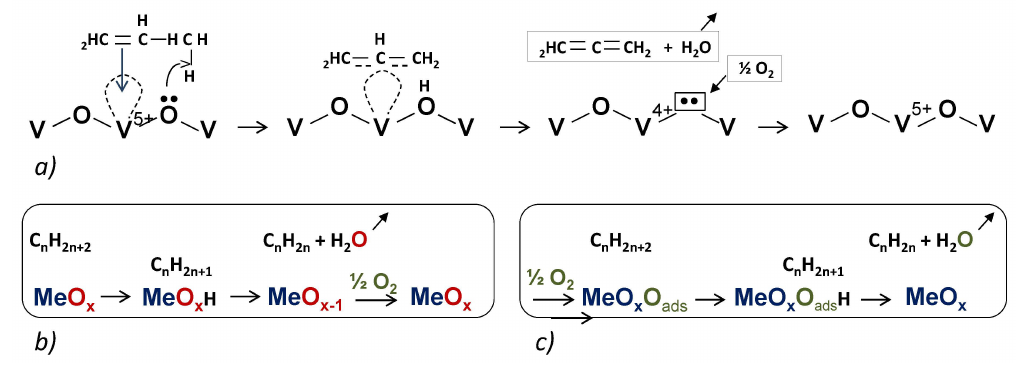
Figure 2. Simplified schemes of: ( a ) propene adsorption O–V–O and formation of a π -allyl complex intermediate; ( b ) case of an alkane; ( c ) effect of adsorbed